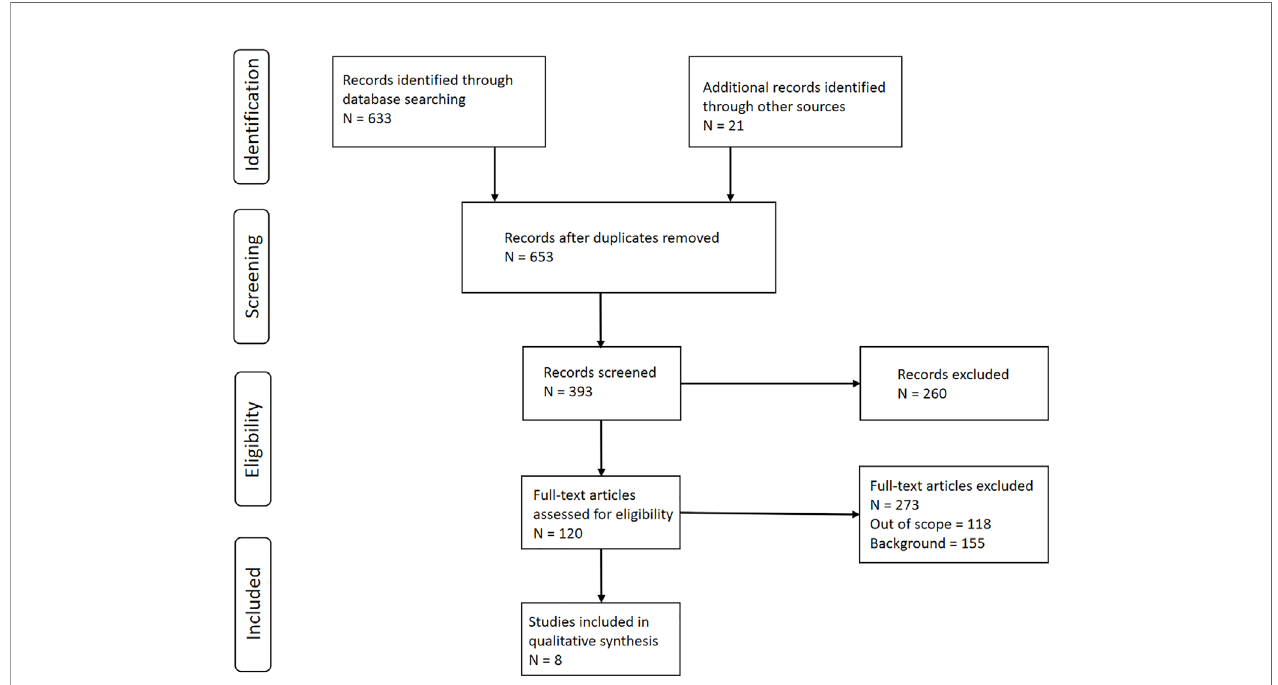
FIGURE 1 | Preferred Reporting Items for Systematic Reviews and Meta-Analysis (PRISMA) Diagram. Schematic depicting the literature review process for the development of basal and cutaneous squamous cell carcinoma (BCC and cSCC, respectively) tumor control probability (TCP) models. Created based on Moher D, A Liberati, J Tetzlaff and DC Altman, 2009 [ref